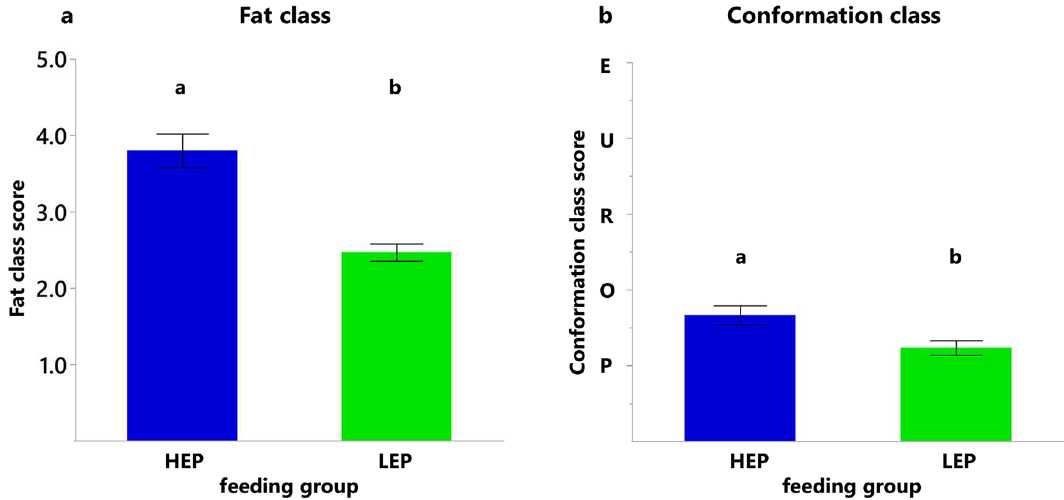
Figure 3. Carcass performance. ( a ) Fat class and ( b ) conformation class at slaughter. Data shown as means ± SEM, n = 15, different letters indicate significant difference (P < 0.05). HEP = group fed high energy and protein diet, LEP = group fed low energy and protein diet.